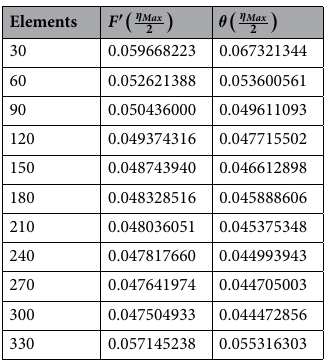
Table 2. Illustration of numerical values of θ